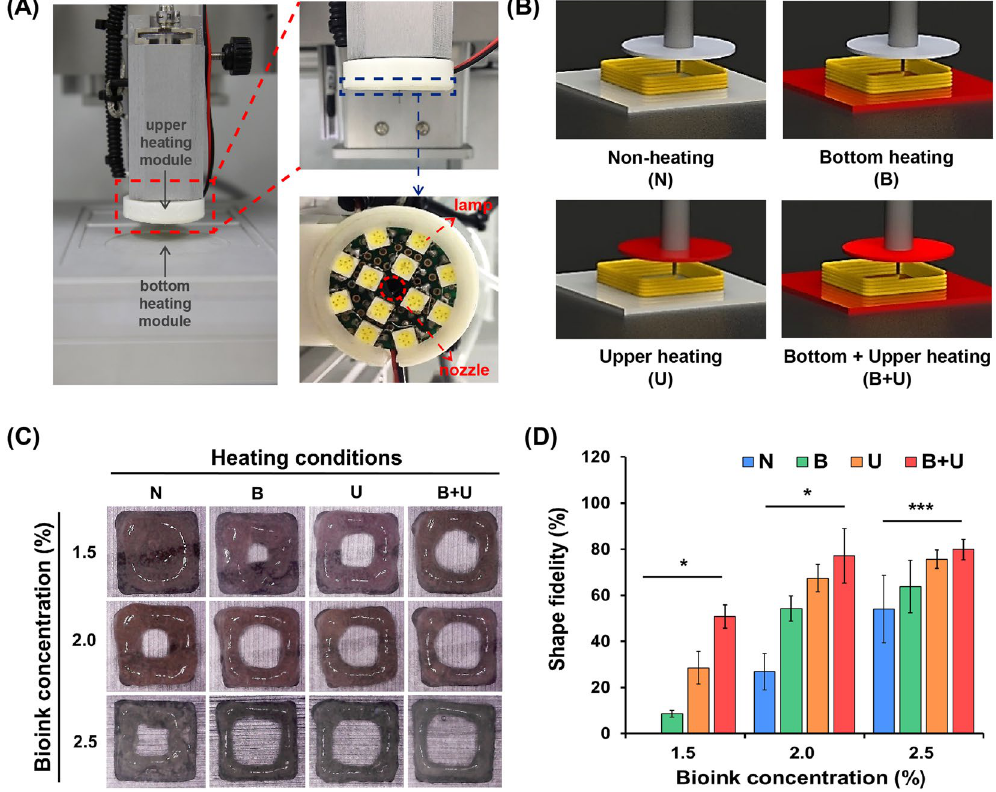
Figure 5. Heating systems and their efficacy. ( A ) Photographs of the upper and bottom heating modules installed in 3D printing equipment. ( B ) Conceptual diagram of non-heating and heating conditions. ( C ) Representative optical images of 3D-printed hollow-type squares, and ( D ) Quantitative analysis of shape fidelity under different bioink concentrations and various heating conditions. ( * p < 0.001, *** p <